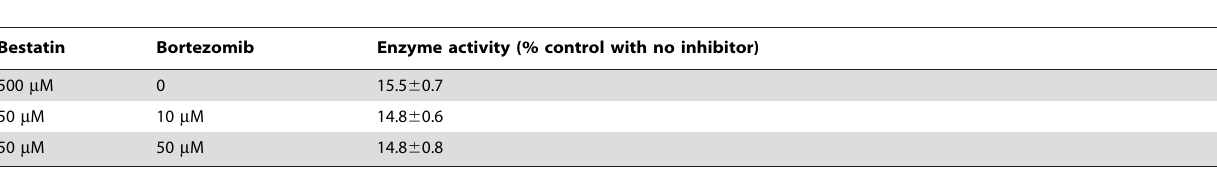
Table 4. Enzyme activity of HEK293T cell extracts assayed with Ala-AMC in the absence or presence of various inhibitors.